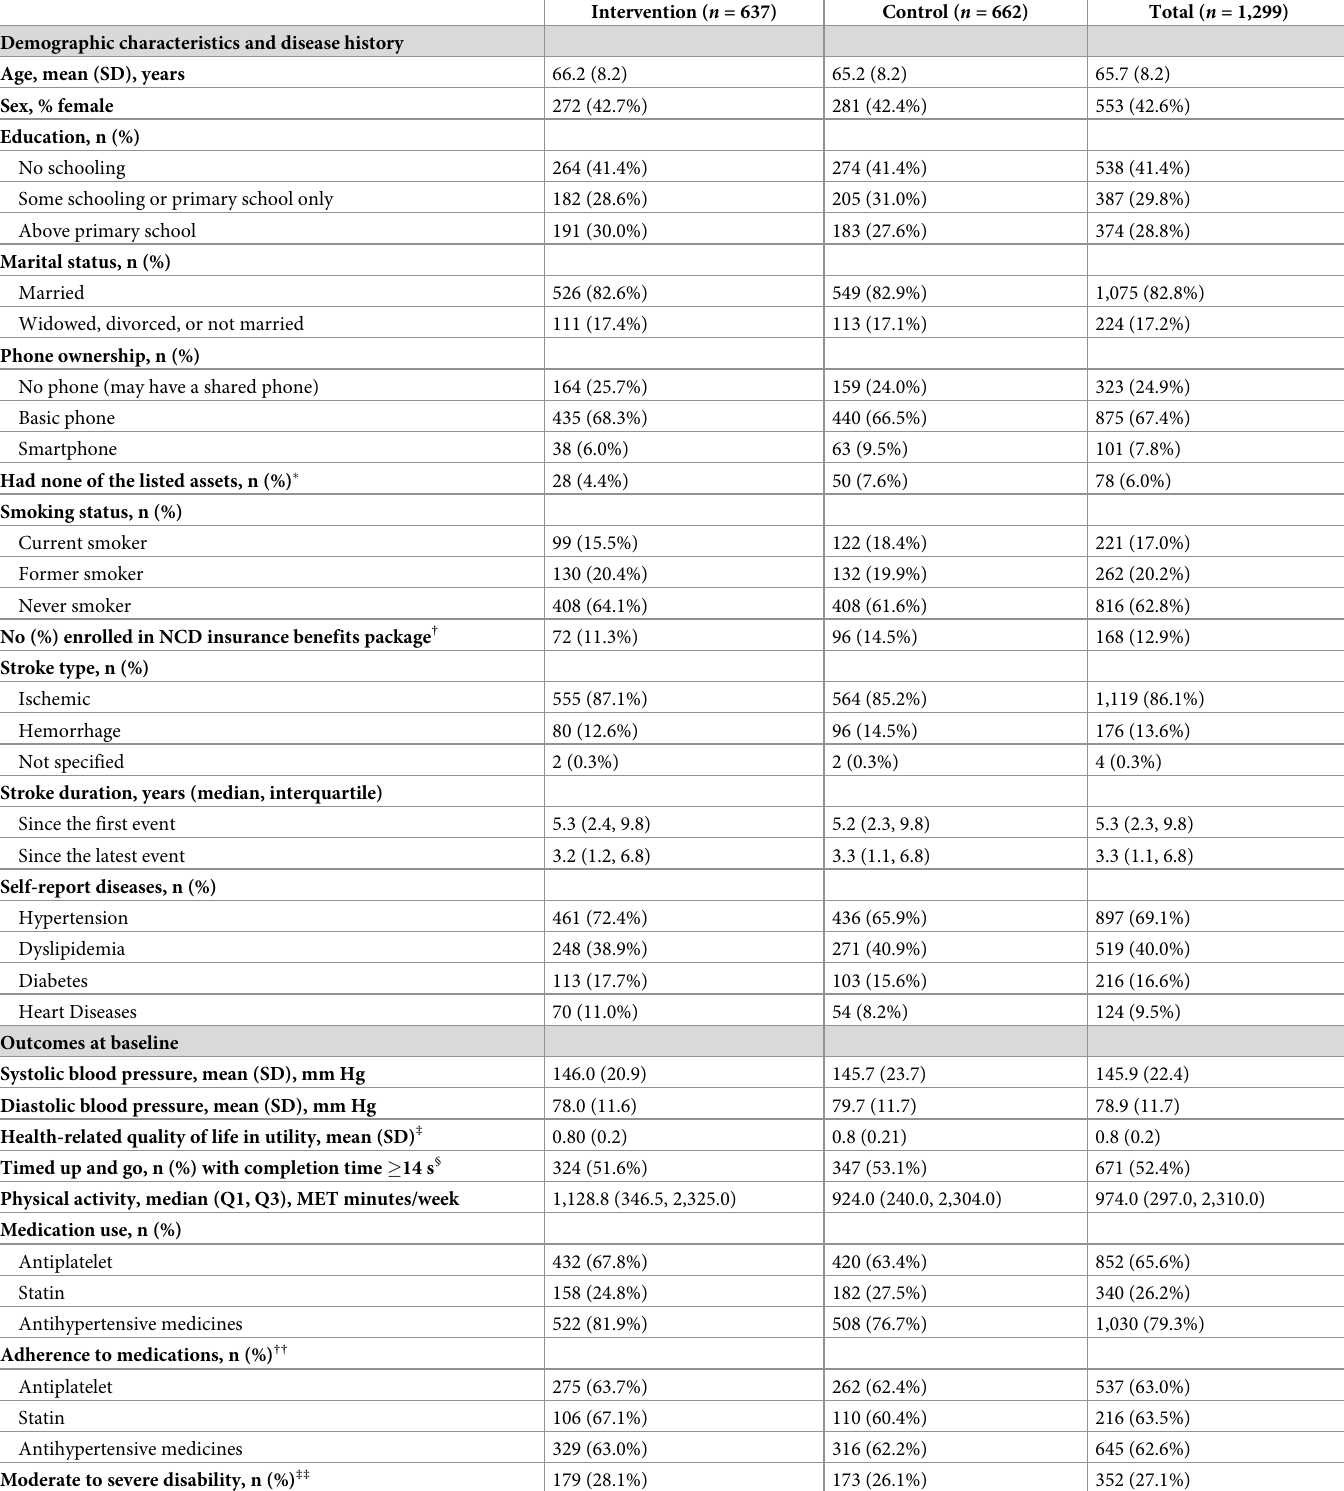
Table 1. Baseline characteristics for the SINEMA trial at the patient